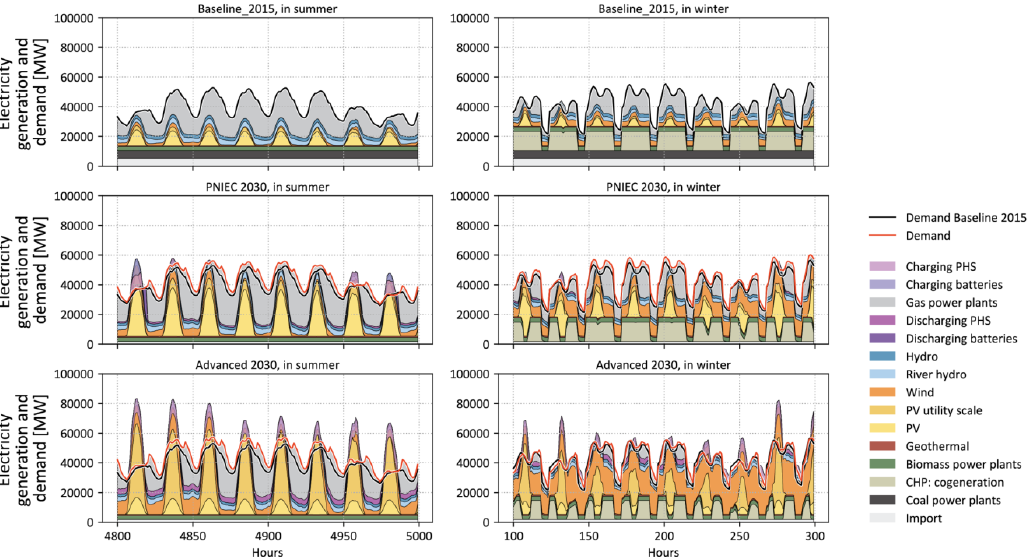
Figure 9. Hourly electricity dispatch for two weeks of the year (one in summer and one in winter) for the scenarios Baseline 2015, PNIEC 2030 and Advanced 2030.